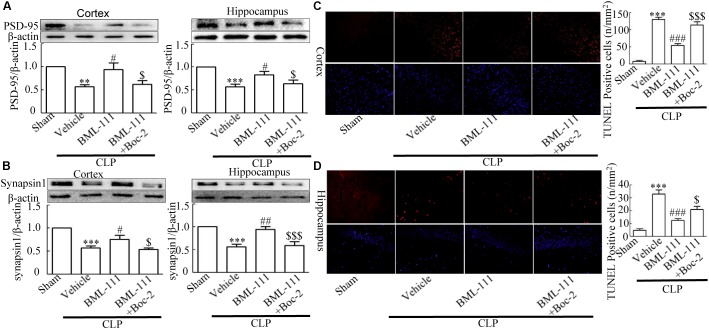
BML-111 treatment reduces the decreases in PSD95, Synapsin1 and TUNEL-positive cells. PSD95 and Synapsin1 (A,B) in the cortex and hippocampus were significantly reduced in CLP mice compared with the sham group. BML-111 treatment increased the expression of PSD95 and Synapsin1 in CLP mice, and Boc-2 decreased the effects of BML-111. (C,D) The number of TUNEL-positive cells was significantly increased in CLP mice compared with the sham group. BML-111 treatment reversed this variation in CLP mice, and Boc-2 reduced these effects. Scale bars indicate 20 mm. Data were shown as the means ± SEM (n = 6 surviving mice in A cortex, n = 5 surviving mice in A hippocampus, n = 6 surviving mice in B cortex, n = 4 surviving mice in B hippocampus, n = 3 surviving mice per group in C,D). ∗∗P < 0.01, ∗∗∗P < 0.001 represent CLP + Vehicle vs. Sham, #P < 0.05, ##P < 0.01, ###P < 0.001 represents CLP + BML-111 vs. CLP + Vehicle, $P < 0.05, $$$P < 0.001 represents CLP + BML-111 + Boc-2 vs. CLP + BML-111 in this Figure.